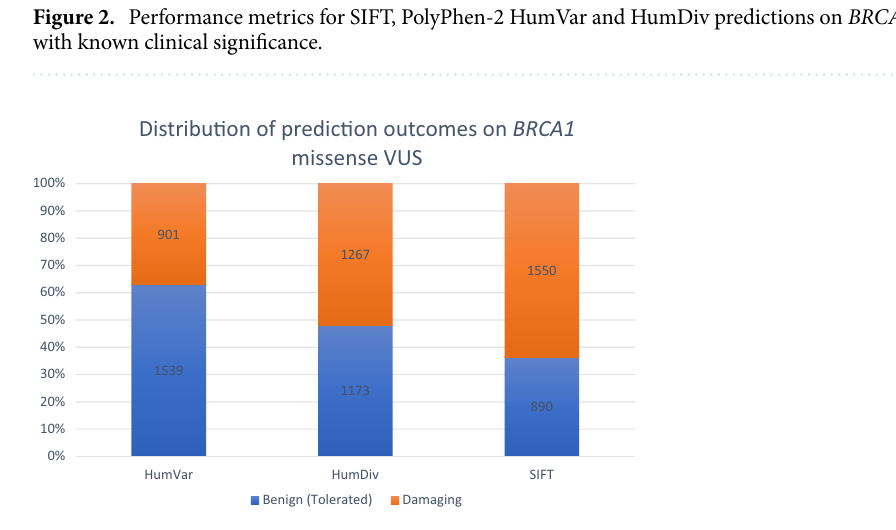
Figure 3. Summary of distribution of prediction outcomes on BRCA1 missense